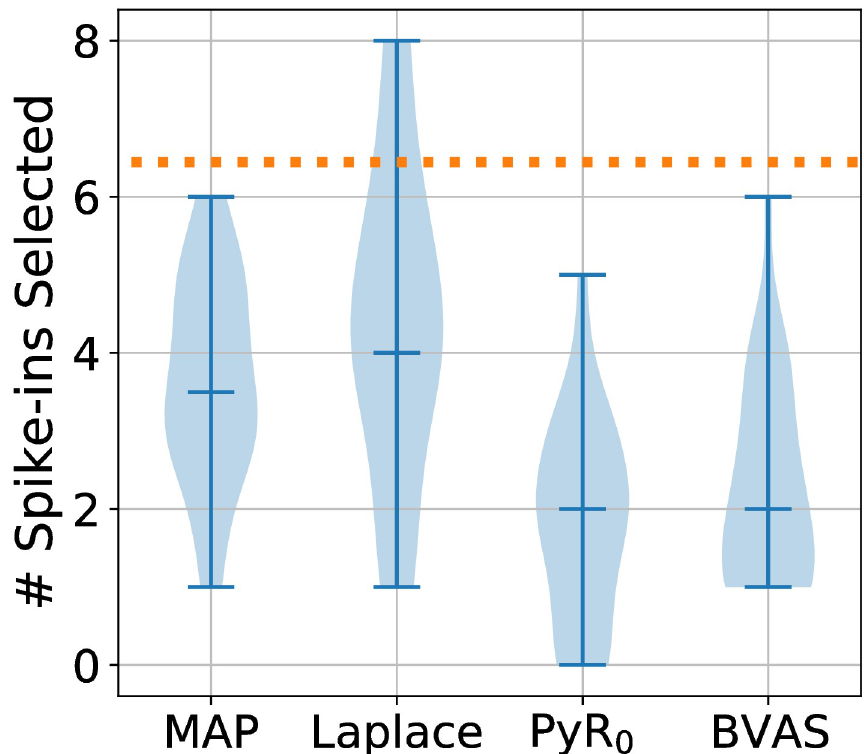
Fig 6. Semi-synthetic spike-in experiment. We compare the robustness of four methods for inferring allele-level selection effects to the addition of spiked-in alleles. We depict the total number of spiked-in alleles that are among the top 100 scoring alleles, where the horizontal line within each violin plot denotes the median and for consistency we rank alleles by the absolute value of the selection coefficient β . The orange dotted line corresponds to the number of spiked-in alleles that would be expected among the top 100 alleles if alleles were ranked at random. We report results from 30 independent